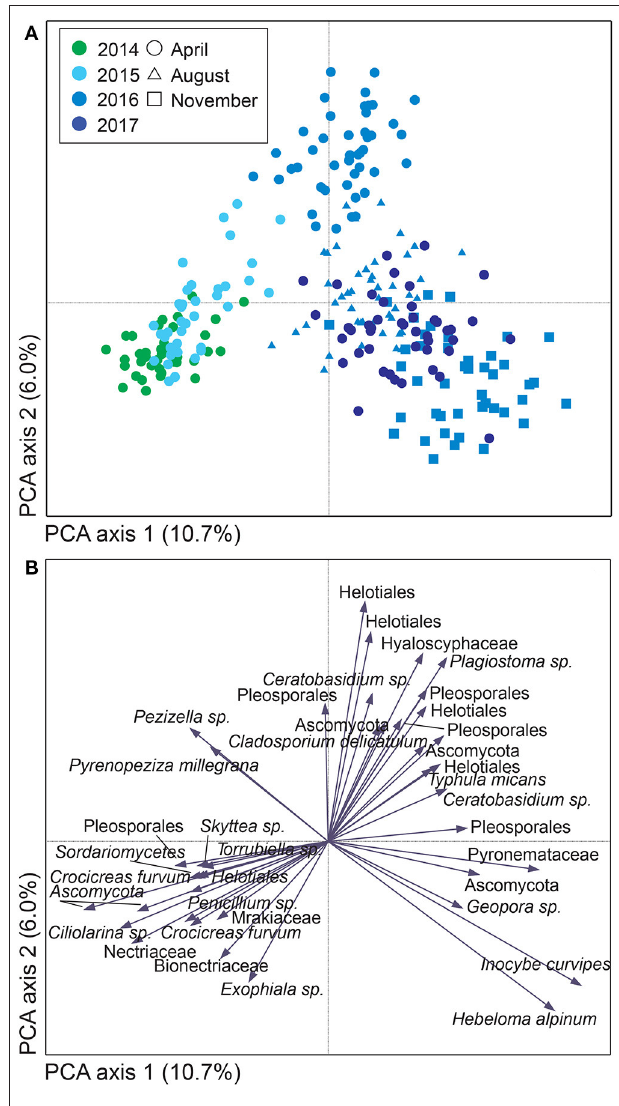
FIGURE 5 | Variation in soil fungal community composition in Salix genotype trial with four genotypes “Björn,” “Jorr,” “Loden” and “Tora” planted in monoculture and various genotype mixtures (2-, 3-, and 4-mixtures) in Uppsala, Sweden. Community composition is visualized by (A) a sample plot and (B) a species plot of a principle component analysis (PCA) based on PacBio sequencing of amplified ITS2 markers. The PCA was based on 442 identified fungal SHs, rarefied data. Symbols are color coded according to: (A) year, with symbol shape indicating sampling month. In (B) , only the 40 most abundant SHs are shown. Axes 1 and 2 explained 10.7 and 6.0%, respectively, of a total inertia of